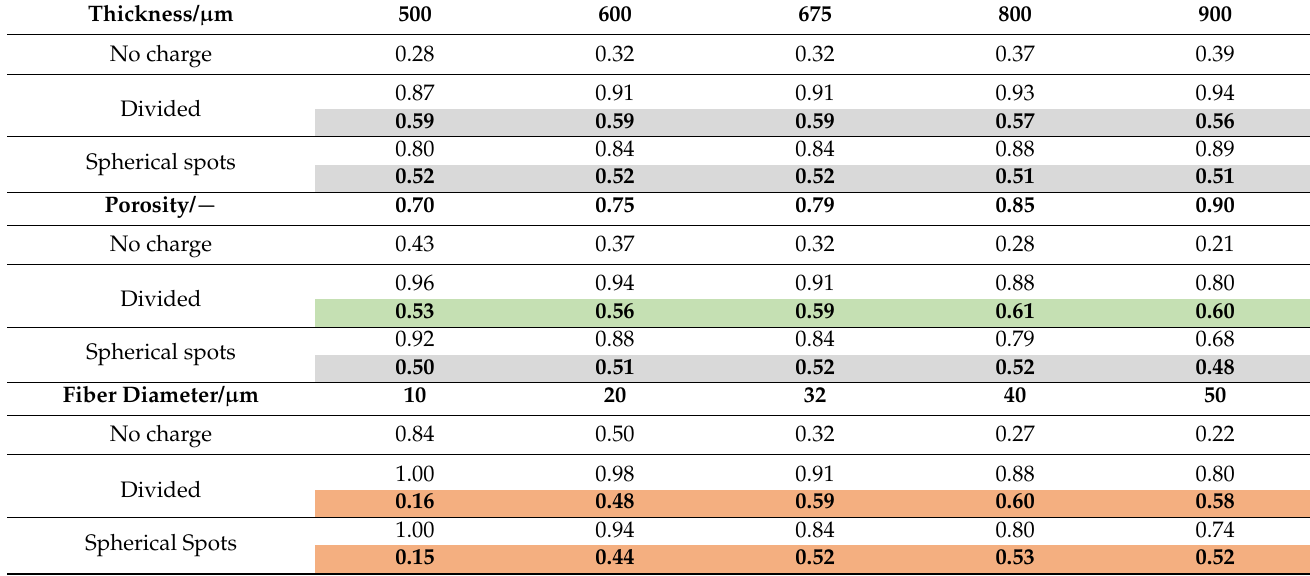
Table 6. Averaged filtration efficiencies, depending on the thickness, porosity, and fiber diameter of the fibrous structure, for both applied cases of charge